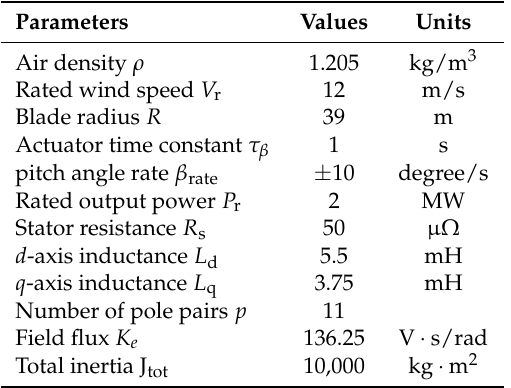
Table 1. Parameters of PMSG-WT for simulation studies.